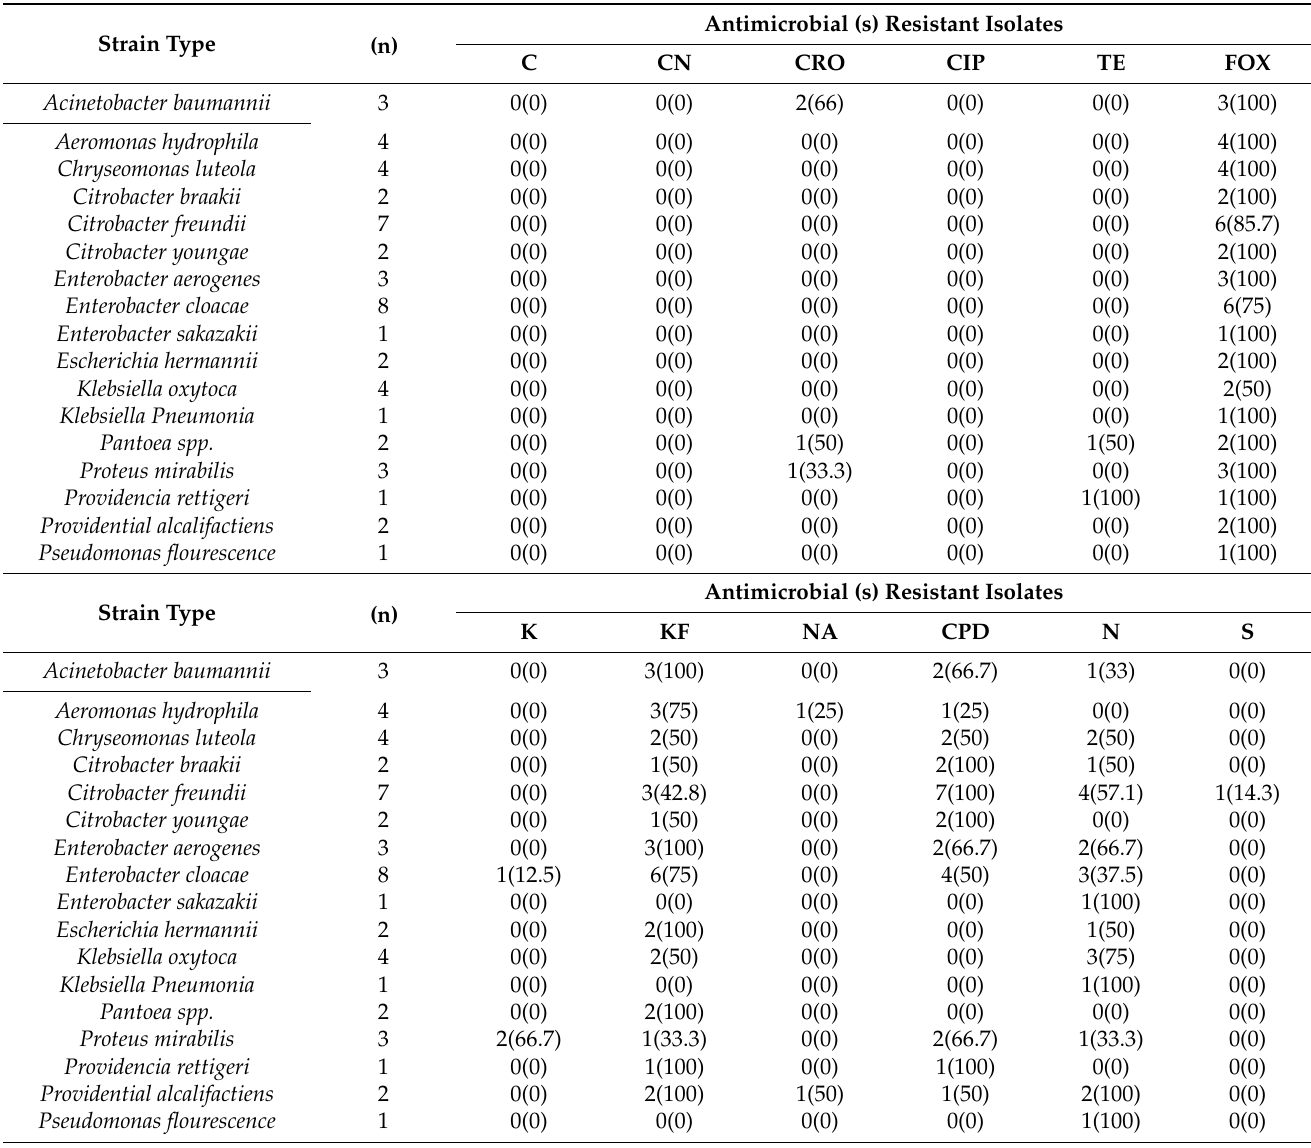
Table 2. Sensitivity of Enterobacteriaceae strains isolated from watermelon to antibiotics.